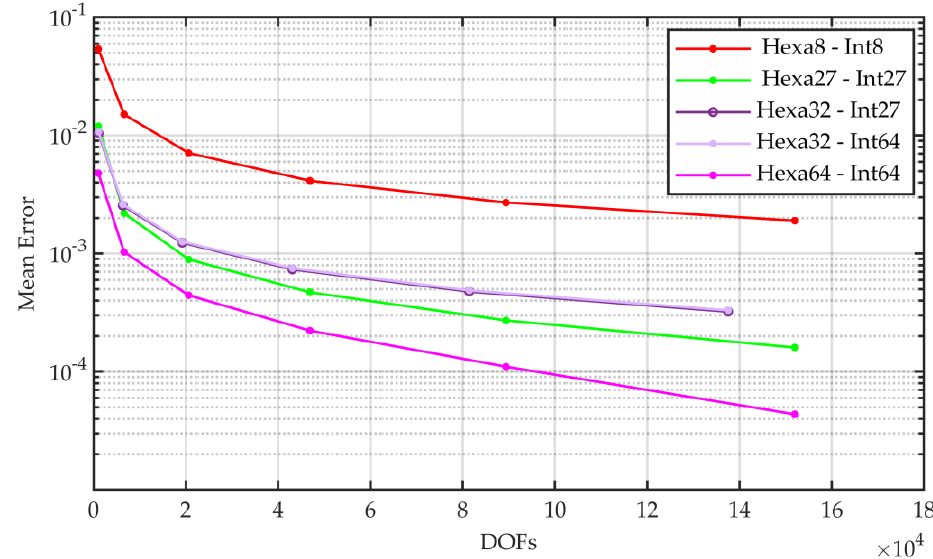
Figure 4. Convergence analysis of three FE formulations (cubic, serendipity 32 − nodes, and seren- dipity 32 − nodes with reduced integration) as a function of the number of DOFs in comparison with linear and quadratic full elements.